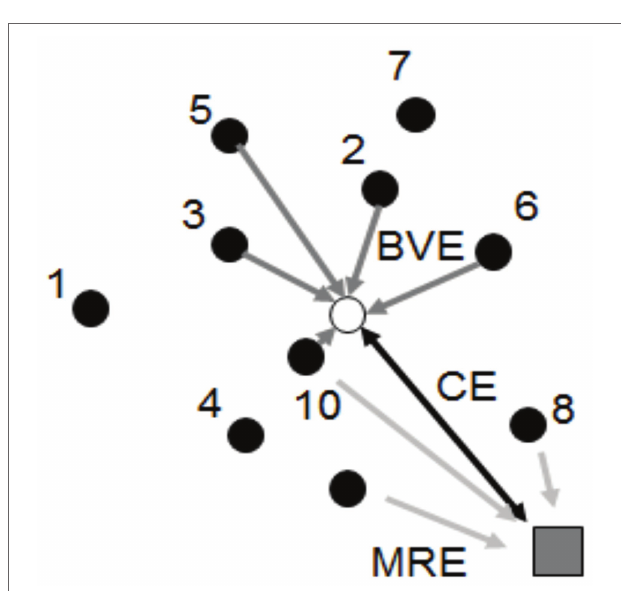
FIGURE 2 | Accuracy measurements for each target. Mean radial error (MRE) was measured as the average of absolute distance to the center of the target. The subject’s own midpoint is measured as the average hit location over all trials per target per subject, whereby the centroid error (CE) is the absolute distance of the subject’s own midpoint to absolute target midpoint. Bivariate variable error (BVE), also referred to as consistency, is the average of the absolute distance to the subject’s own